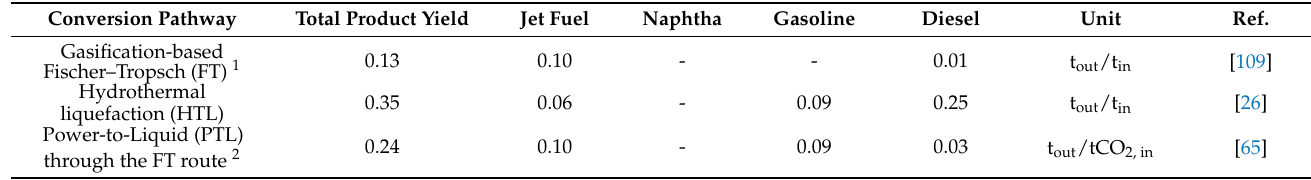
Table 4. Assumed production yields for the included production